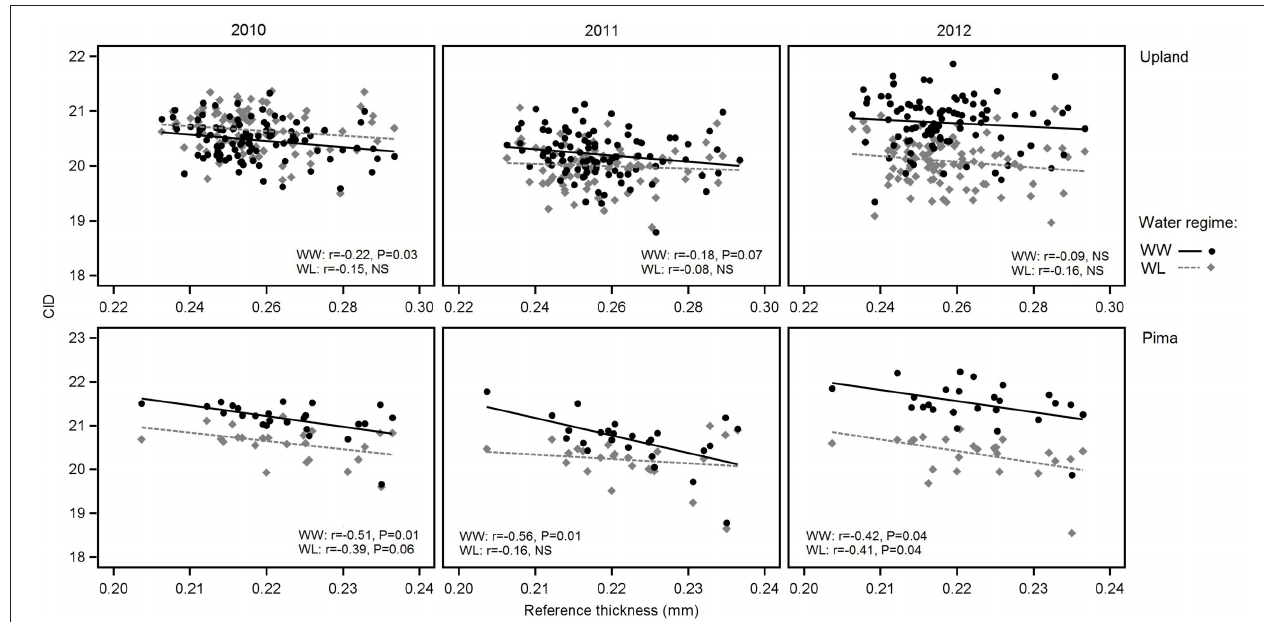
FIGURE 5 | Variation in carbon isotope discrimination (CID) in relation to reference leaf thickness for 2010, 2011 and 2012 and the two irrigation regimes. The upper three graphs are for upland RILs, and the lower three are for the Pima diversity panel. Lines indicate regression trends for each irrigation regime. Note difference in scales for upland vs. Pima